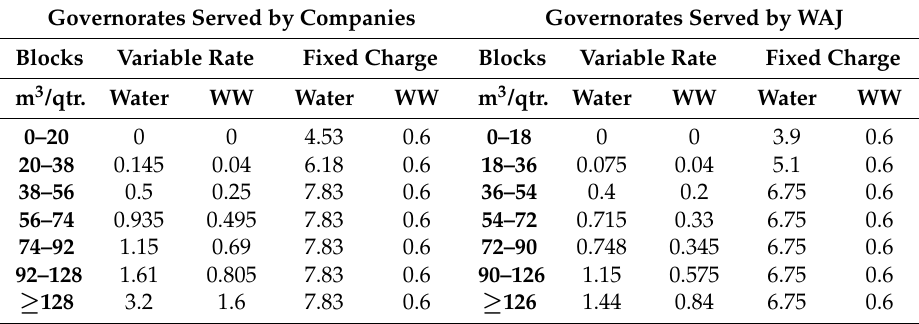
Table 4. Piped water tariff structures for residential users in Jordan,